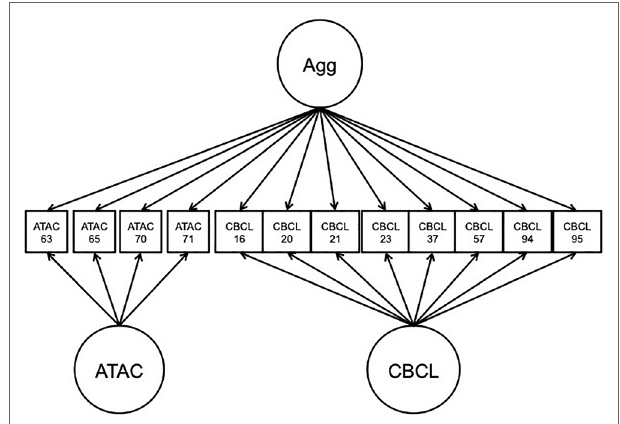
FIGUre 5 | Path diagram of bi-factor integration model application to Aggression in Children: Unraveling gene-environment interplay to inform Treatment and InterventiON strategies data. Agg, overt aggression factor; CBCL, child behavior check-list; ATAC, autism-tics, attention-deficit hyperactivity disorder, and other comorbidities